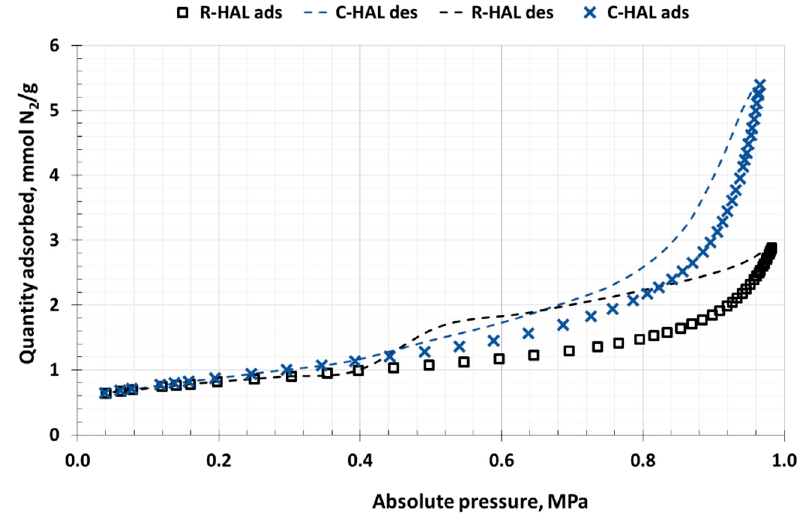
Figure 5. N 2 sorption isotherms of halloysites R-HAL and C-HAL, 77K (LPNA method) .